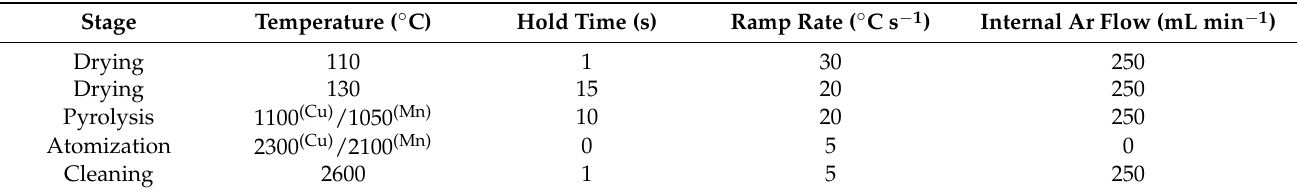
Table 5. Operation conditions for ETAAS determinations.